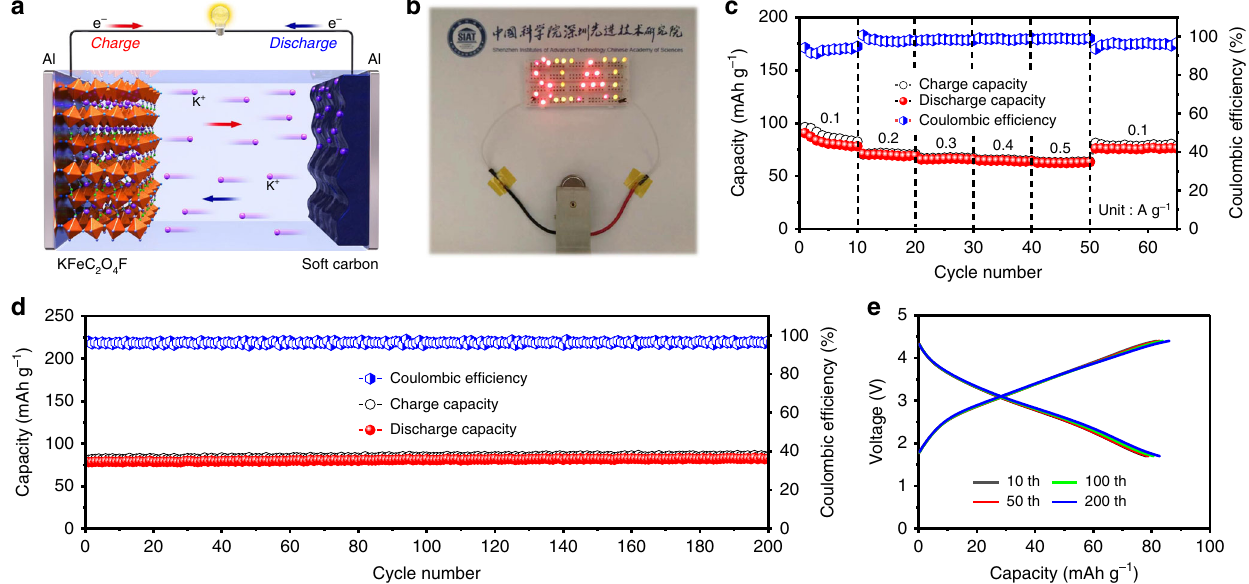
Fig. 6 Electrochemical measurements of full K ion cell in 1.7 – 4.4 V. a Schematic illustration of working mechanism. b Lit LED screen driven by a K ion full cell. c Charge – discharge capacities and corresponding coulombic ef fi ciency of a full cell under different current densities. d Cycling performance of a full cell at 0.1 A g − 1 , and e the corresponding charge – discharge curves of different